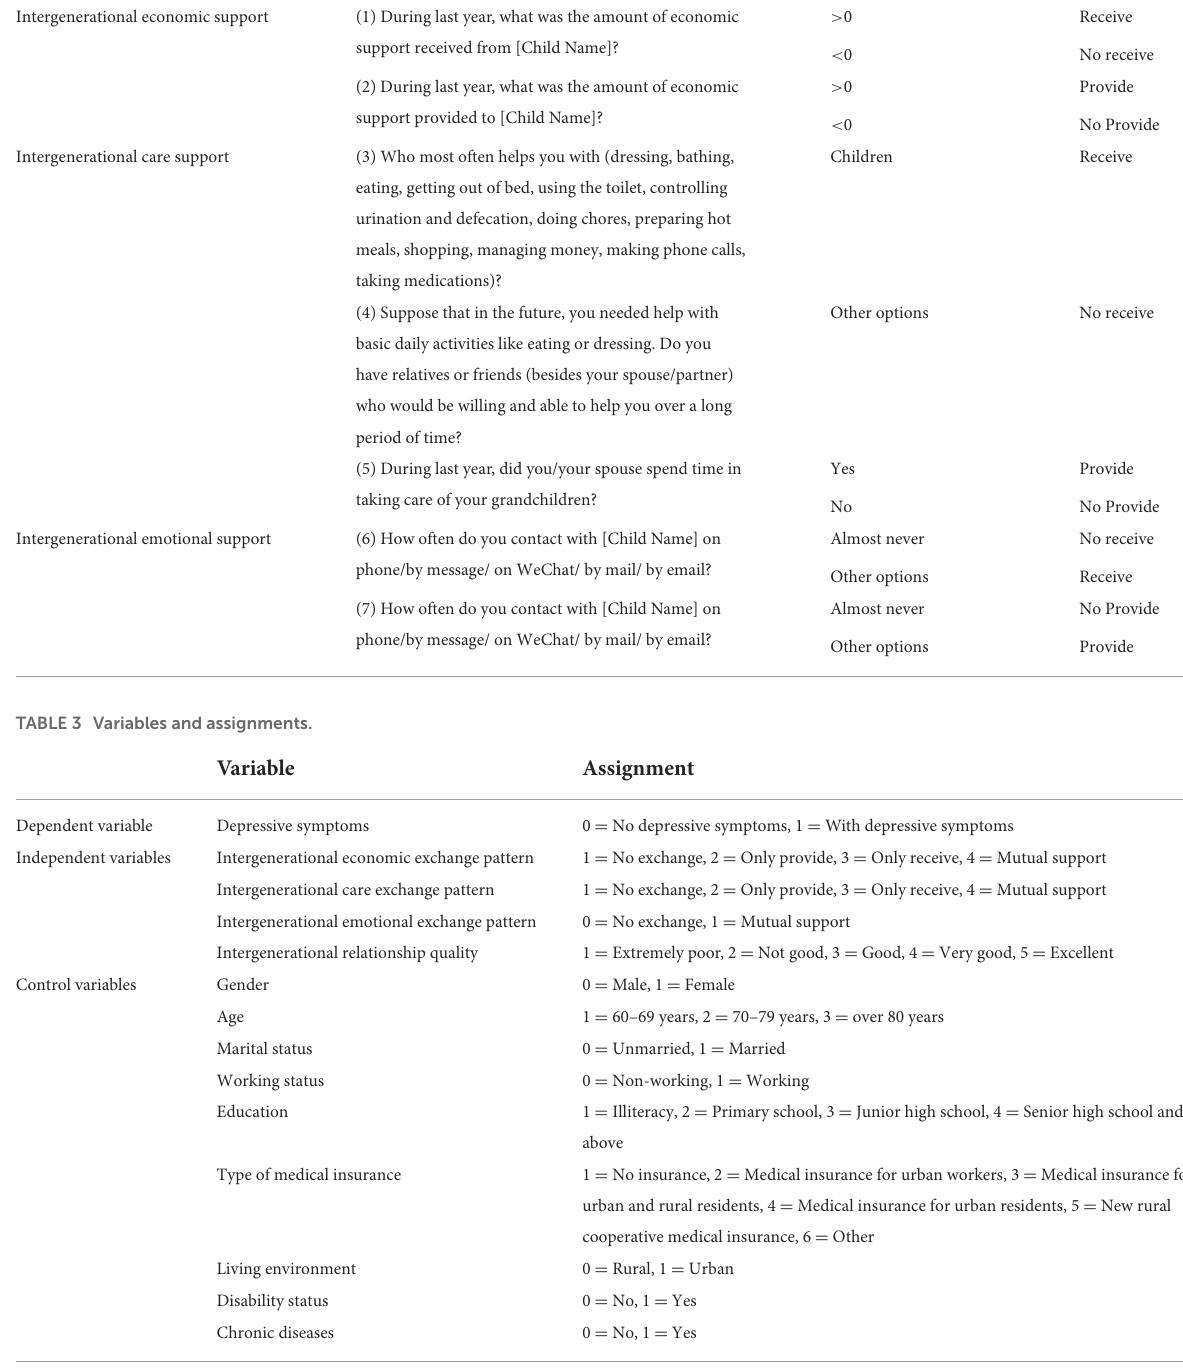
TABLE 2 Questionnaire of intergenerational support. Scale